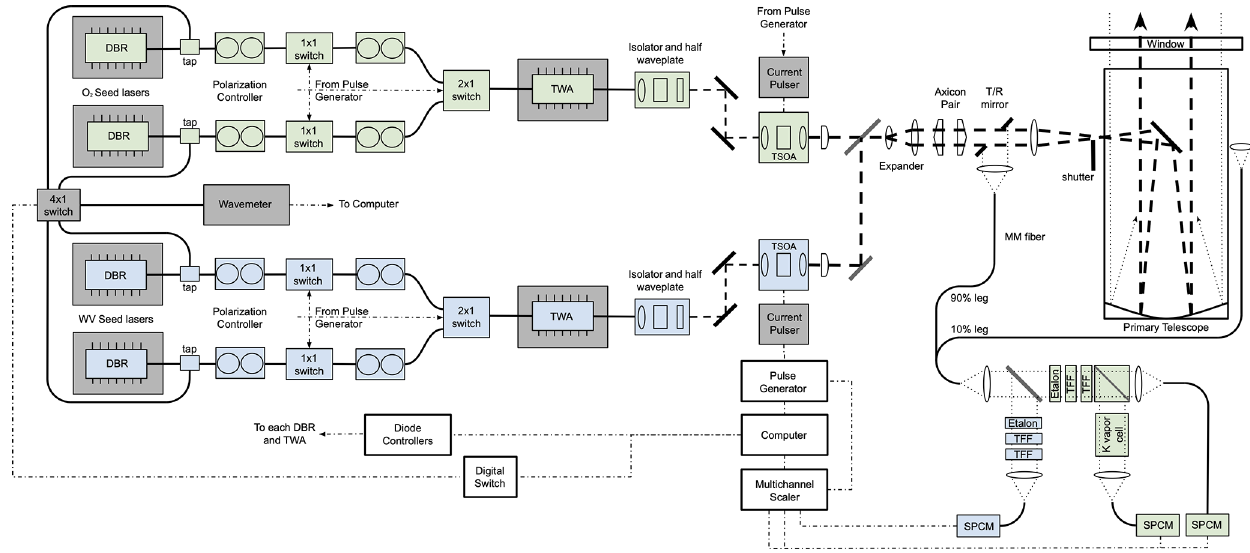
Figure 1. The Gen 5 MPD schematic shown configured with water vapor (blue) and temperature (green). Note that power monitoring is not shown in the schematic. Abbreviations used: distributed Bragg reflector (DBR), traveling wave amplifier (TWA), tapered semiconduc- tor optical amplifier (TSOA), transmit/receive mirror (T/R), multimode (MM), thin-film filter (TFF), and single-photon-counting modules